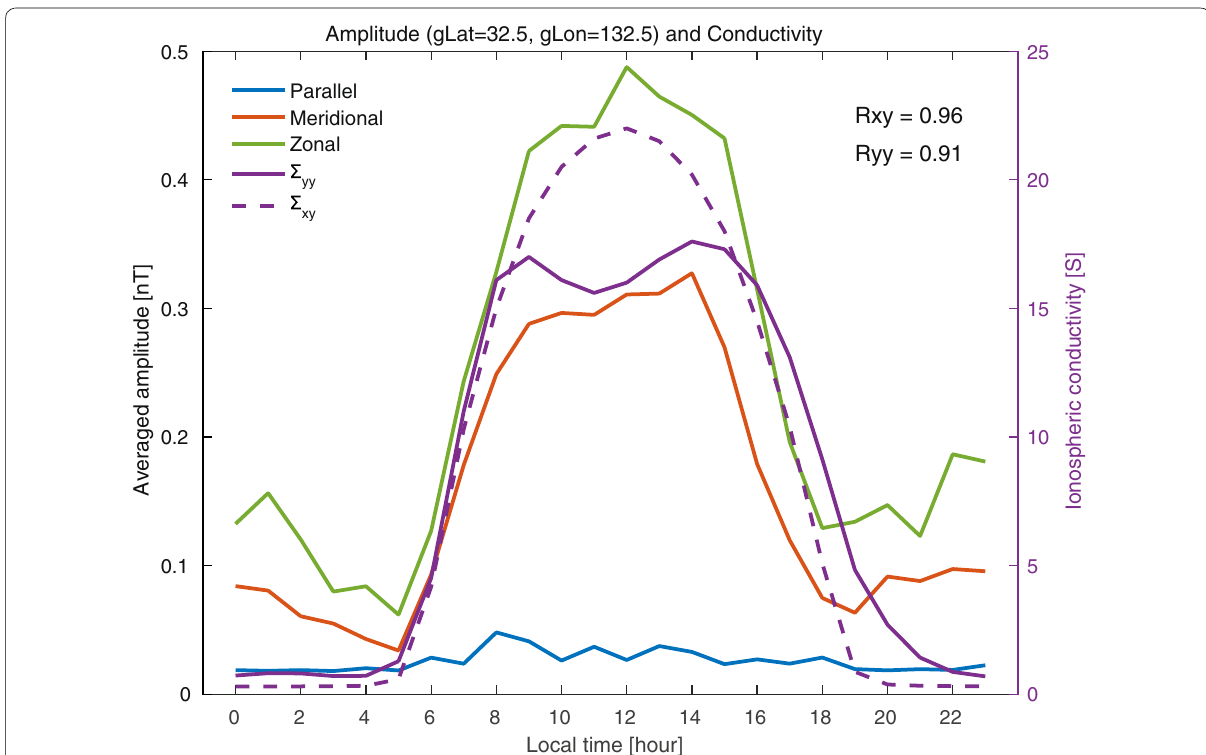
Fig. 3 LT dependence of the average amplitudes and two-dimensional ionospheric conductivities. The two-dimensional conductivities, Σ yy and Σ xy , are height-integrated from an altitude of 90–450 km at a location in Japan (33°N, 133°E) on April 2, 2015. X and Y indicate magnetic north and east, respectively. Blue , red , and green lines show the average amplitude of the MRs of the parallel, meridional, and zonal component between 30°N–35°N and 130°E–135°E, respectively. Solid purple and dotted purple lines show Σ yy and Σ xy ,